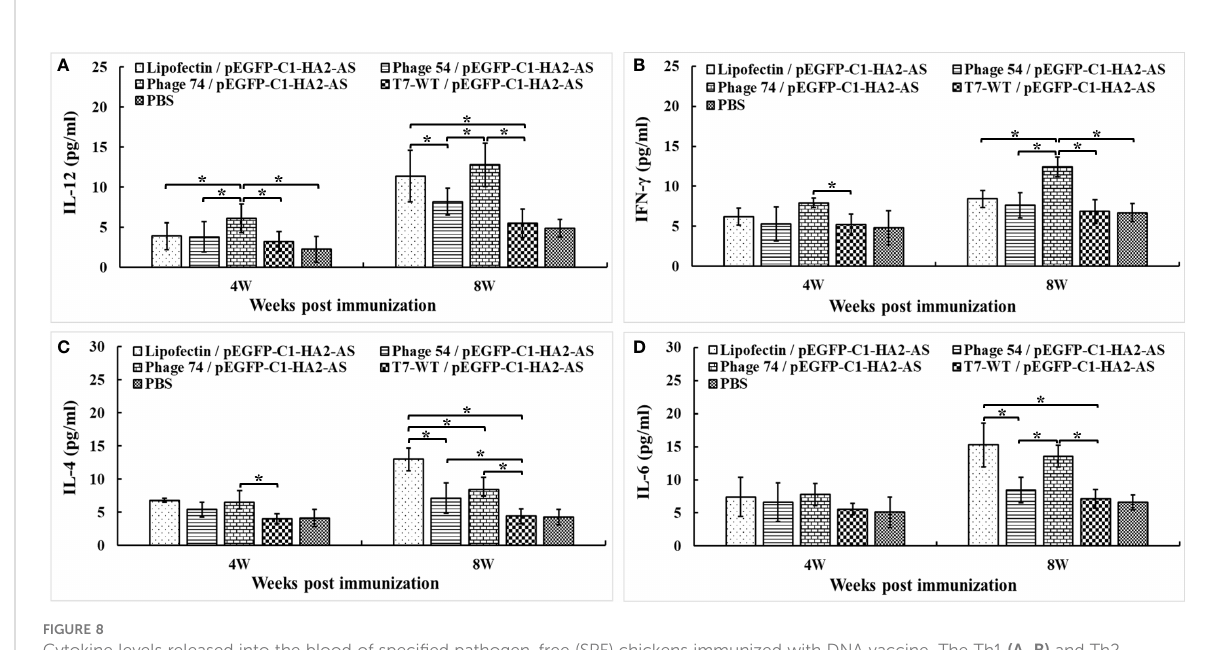
FIGURE 8 Cytokine levels released into the blood of speci fi ed pathogen-free (SPF) chickens immunized with DNA vaccine. The Th1 (A, B) and Th2 (C, D) cell associated cytokines released into the blood at 4 weeks post primary and boost immunization were detected using commercial chicken cytokine detection kits (AndyGene, China). (A) Interleukin-12 (IL-12). (B) Gamma interferon (IFN- g ). (C) Interleukin-4 (IL-4). (D) Interleukin-6 (IL-6). Values represent mean ± S.D. (n = 10). * p < 0.05 was signi fi cantly